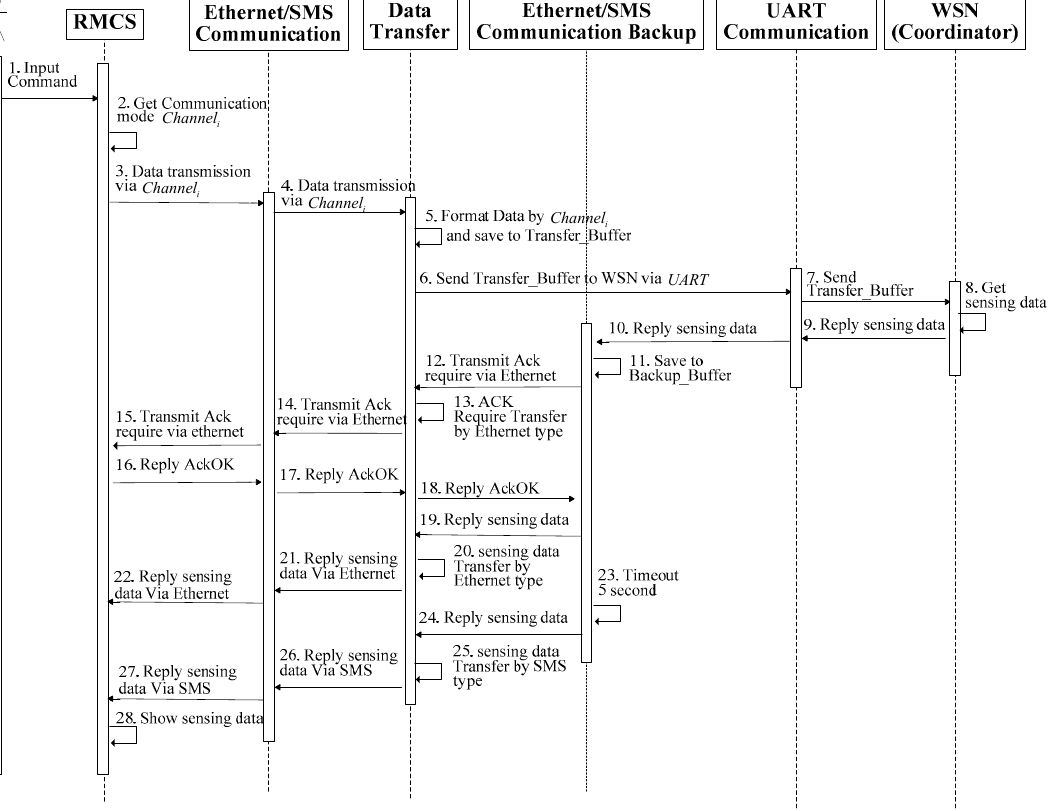
Figure 4. Operational cycle of the embedded communication gateway with automatic back-up capabilities.